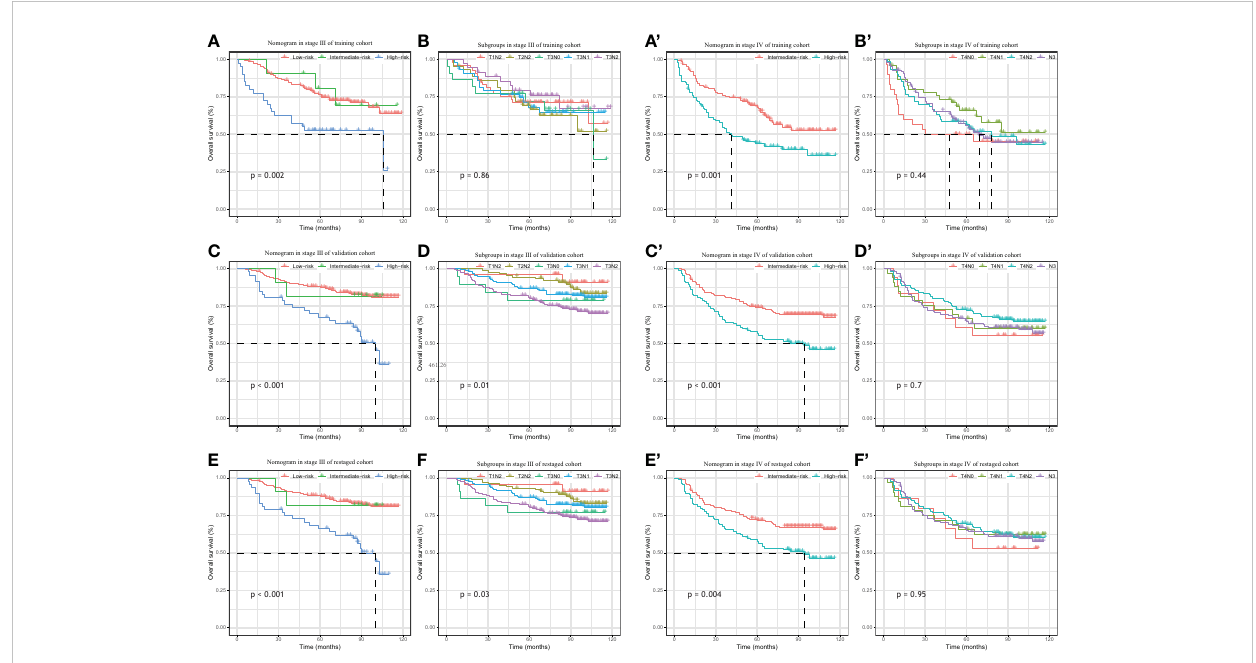
FIGURE 6 Kaplan – Meier survival analysis of overall survival according to the nomogram(left) and the clinical stage subgroup (right) strati fi cation in the patients with stage III & stage IV from training cohort ( A , B , A ’ , B ’ ), external validation cohort ( C , D C ’ , D ’ ) and re-staged cohort ( E , F , E ’ , F ’